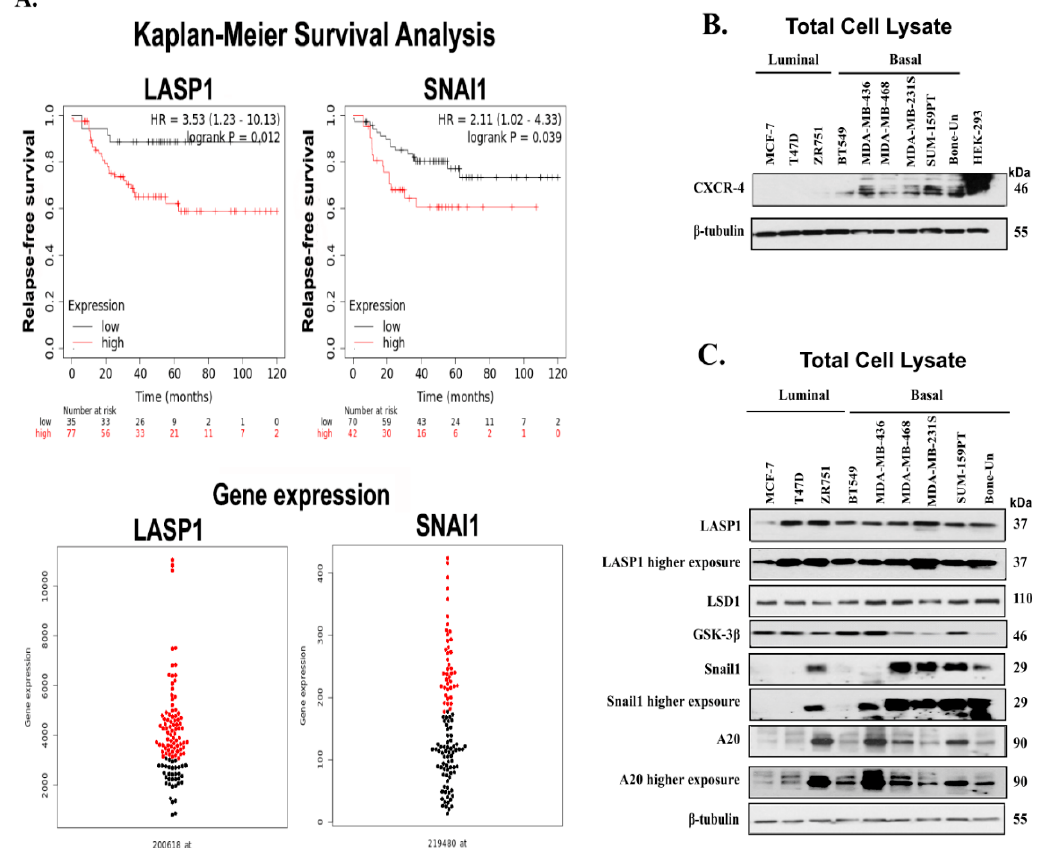
Figure 1. CXCR4 and Snail1 are expressed di ff erentially in human breast cancer cell lines. ( A ) Top panel—Kaplan–Meier analysis of the relapse-free survival rate of basal-like, triple-negative breast cancer patients with grade 3 tumors, with a di ff erential expression of LASP1 and SNAI1 ( n = 112). Bottom panel—Beeswarm plot of di ff erential gene expression profile of LASP1 and SNAI1 —red symbols—high expression; black symbols—low expression ( B ). Proteins in the total cell lysates were separated by 10% SDS-PAGE, and subjected to Western blot analysis for di ff erential expression of CXCR4 by probing with anti-CXCR4 antibody in luminal and basal-like breast cancer cell lines. Moreover, β -tubulin served as the loading control ( C ) Proteins in the total cell lysates were separated by 10% SDS-PAGE and subjected to Western blot analysis for di ff erential expression of proteins involved in Snail1 stabilization such as LASP1, LSD1, Snail1, and A20 in luminal and basal-like breast cancer cell lines. Furthermore, β -tubulin served as the loading